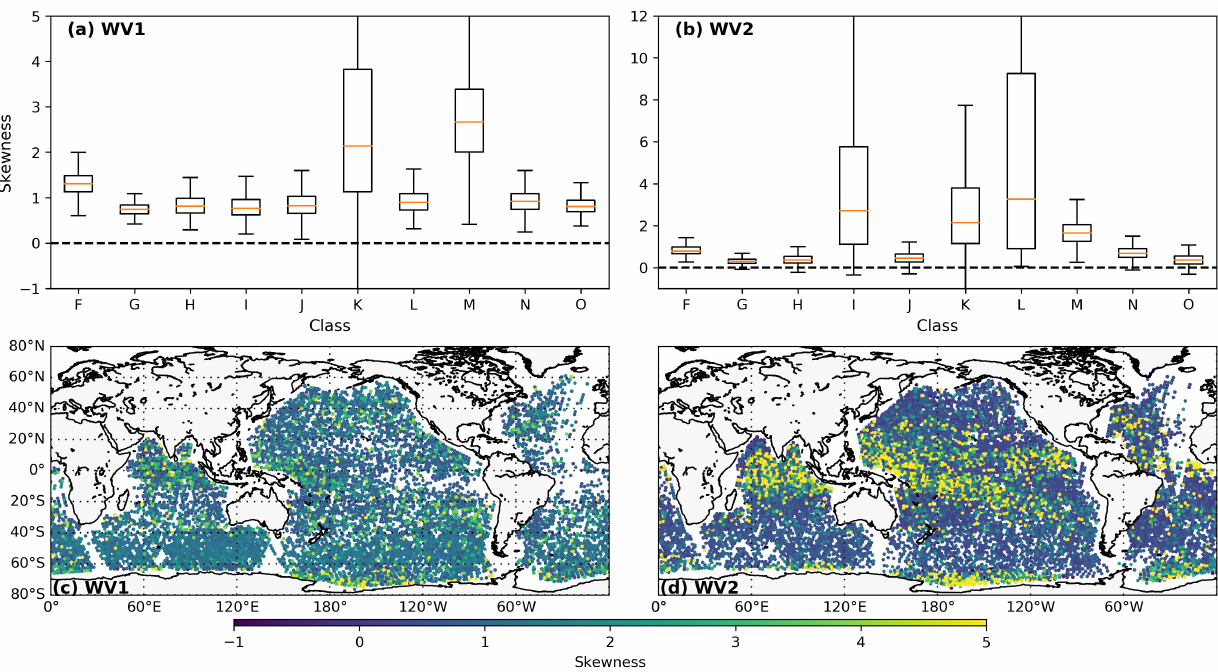
Figure 5. The same as in Figure 4 but for the